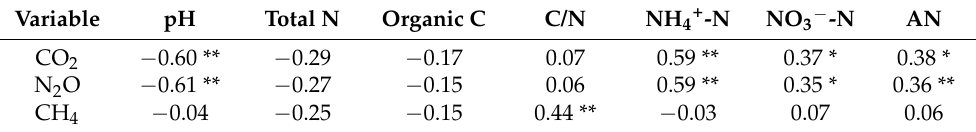
Table 3. Pearson’s correlation coefficients for the correlation among cumulative CO 2 , N 2 O, and CH 4 emissions and initial soil properties ( n = 12).